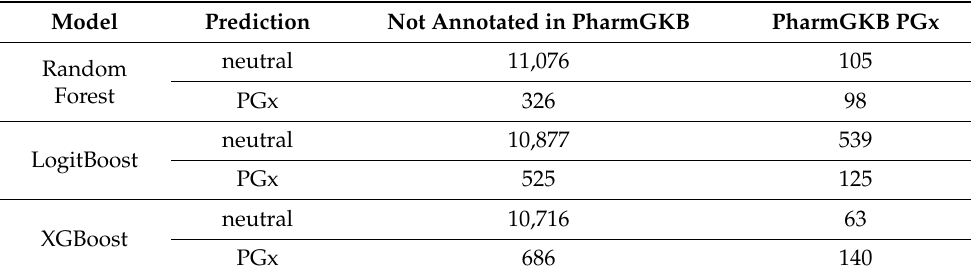
Table 3. Machine learning model comparison using test data.